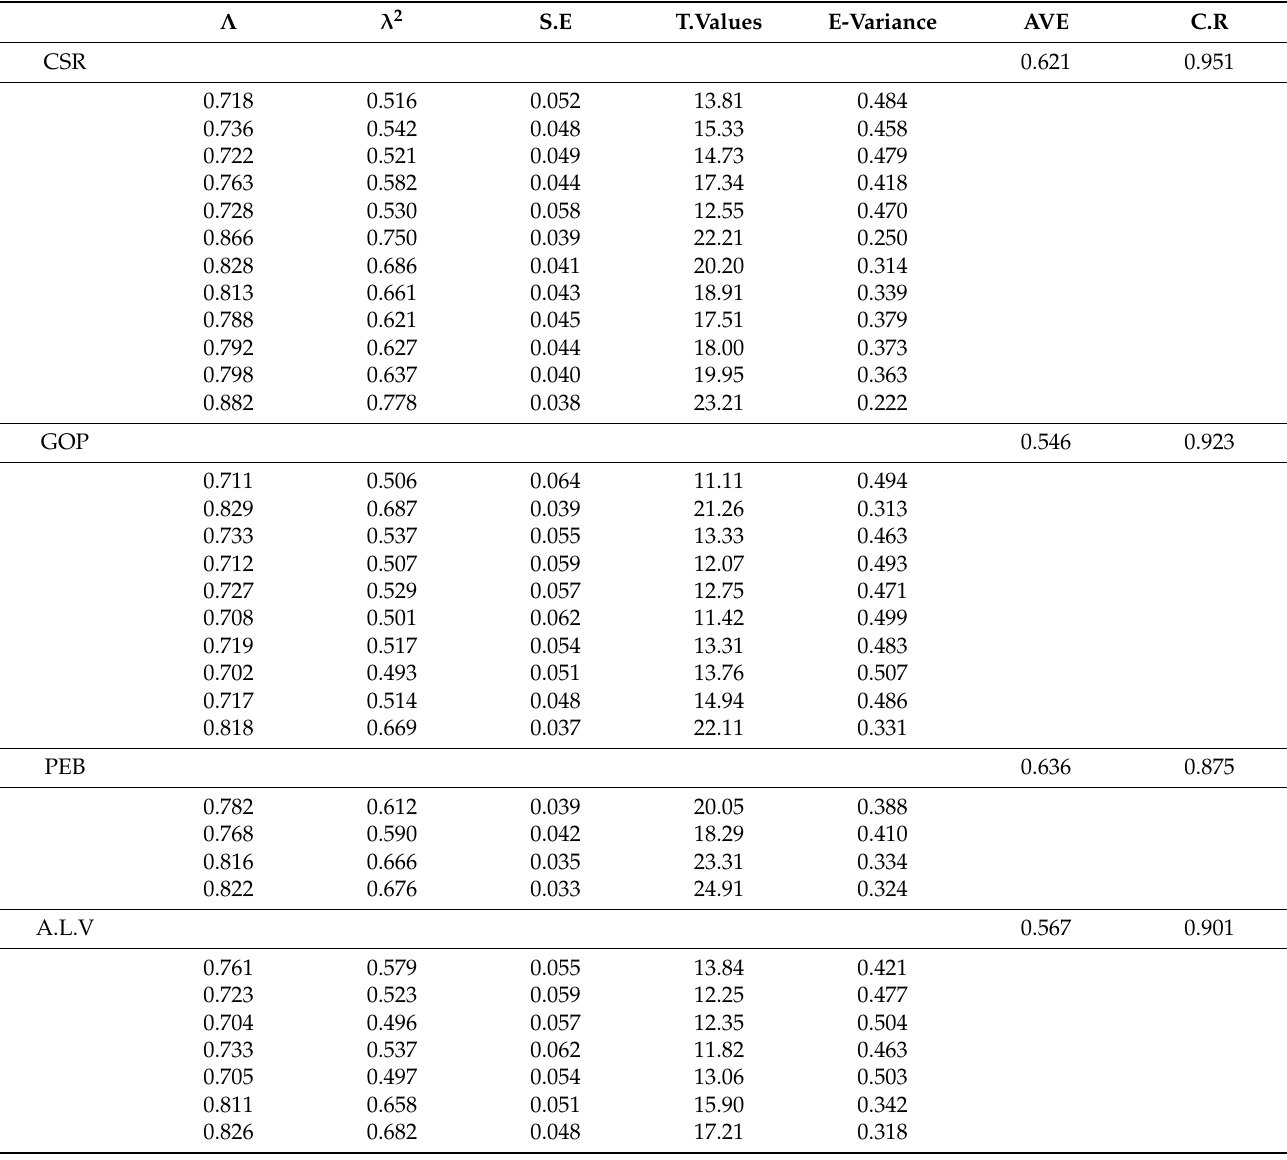
Table 2. Construct